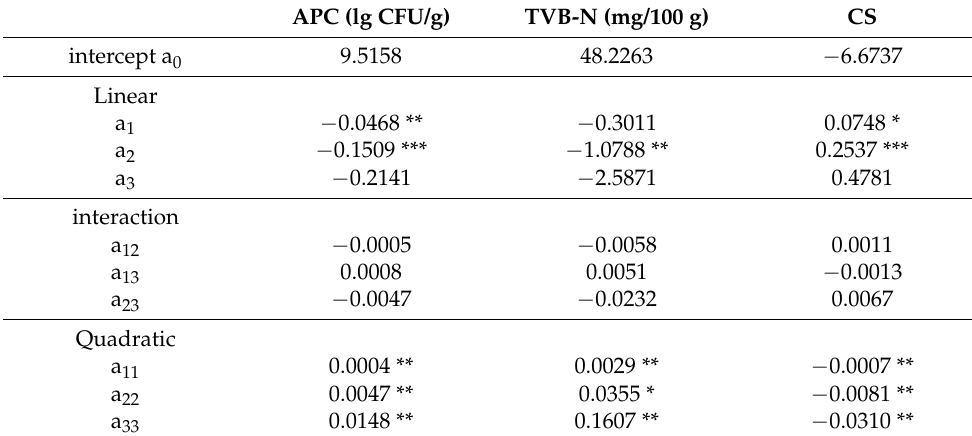
Table 8. Regression coefficients of responses in terms of actual factors that are specified in the original units for each factor.